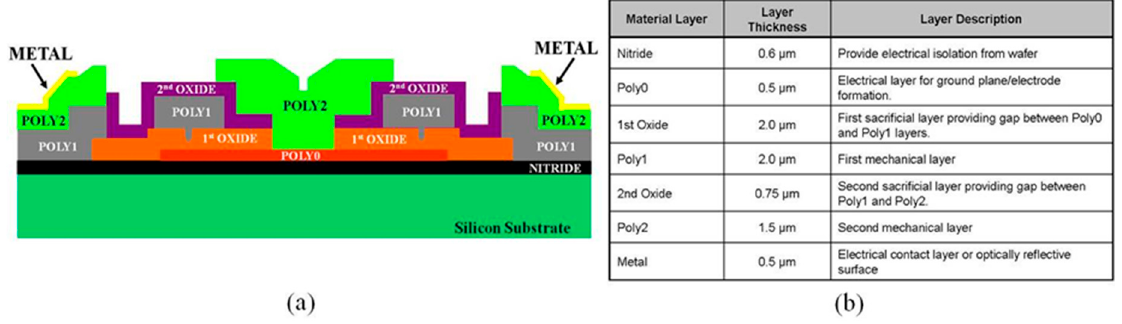
Figure 1. PolyMUMPs foundry fabrication layers are shown in ( a ). The material layer descriptions and thicknesses are given in ( b ) to illustrate the constraints of this foundry process [3].